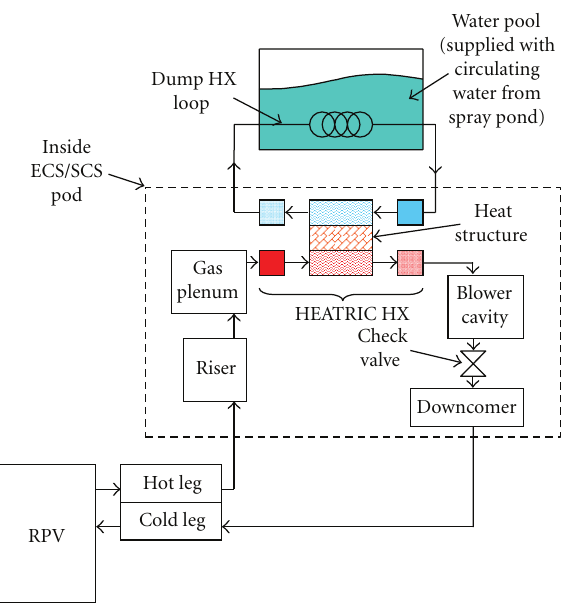
Figure 8: Schematic of emergency cooling system.